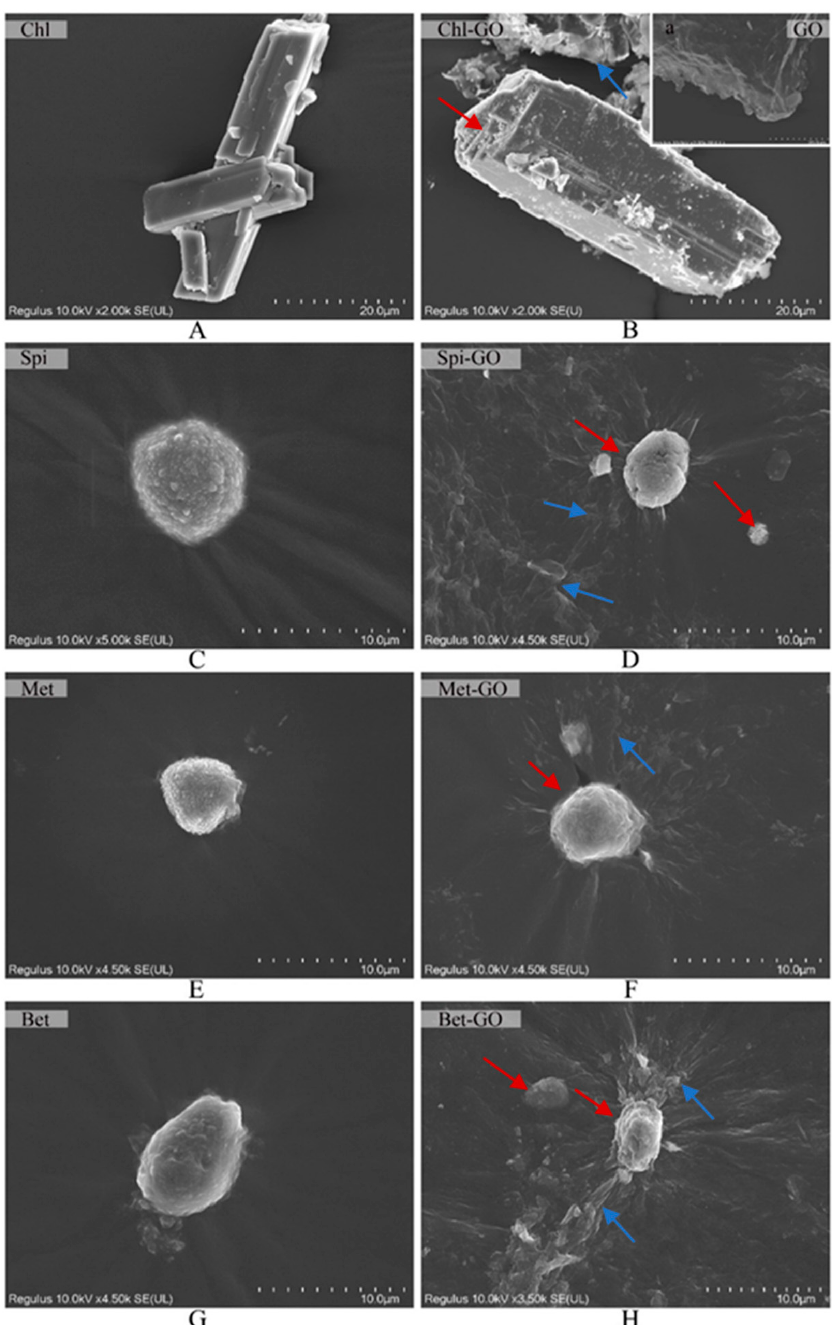
Figure 1. SEM images of GO, pesticide and GO-pesticide nanocomposites. GO (B-a), Chl ( A ), Spi ( C ), Met ( E ), Bet ( G ), Chl-GO at 5:5 ( B ), Spi-GO at 3:7 ( D ), Met-GO at 3:7 ( F ) and Bet-GO at 1:9 ( H ). Red arrows indicate insecticide, blue arrows indicate GO.